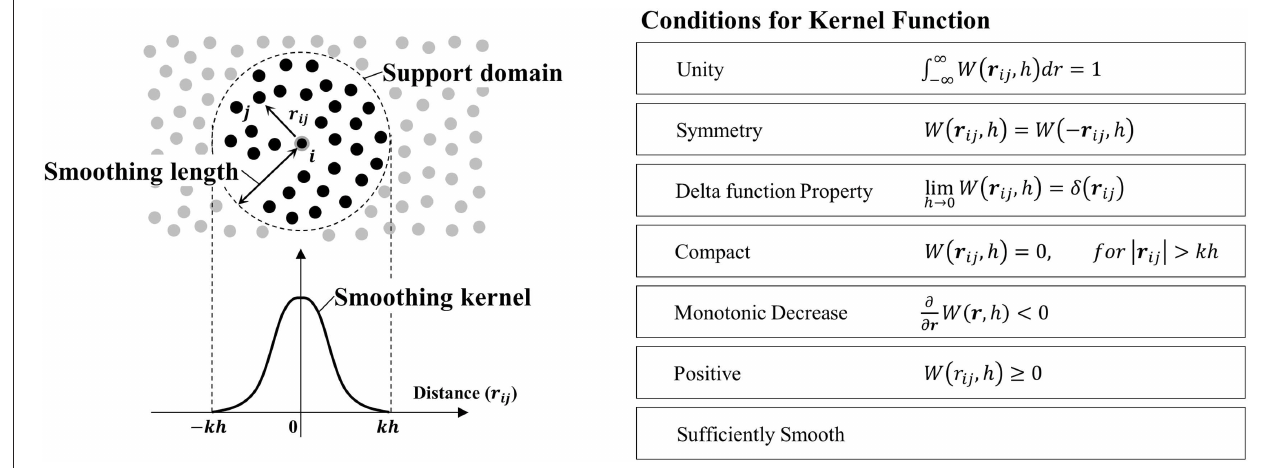
FIGURE 1 | Schematic diagram of SPH kernel